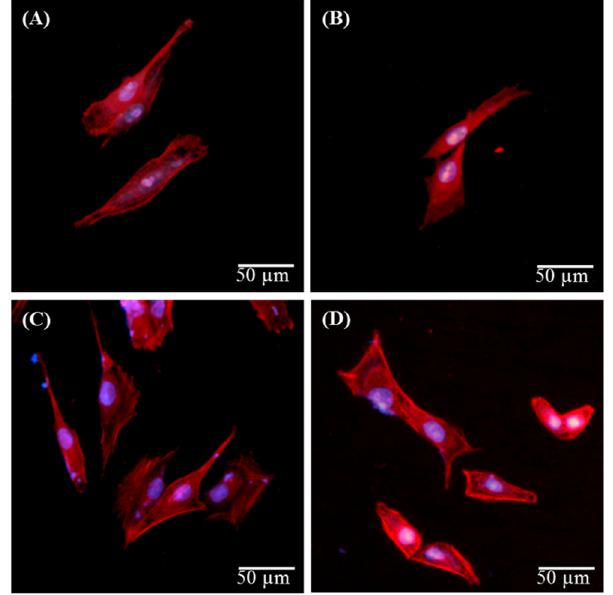
Figure 8. Fluorescent cytoskeleton staining of MG63 cells cultured on ( A ) Ti control; ( B ) 5Ca; ( C ) 10Ca and ( D ) 5CaSi after 6 h of seeding. The cells were stained for nuclei (blue) and actin cytoskeleton (red). Original magnification: 200×.